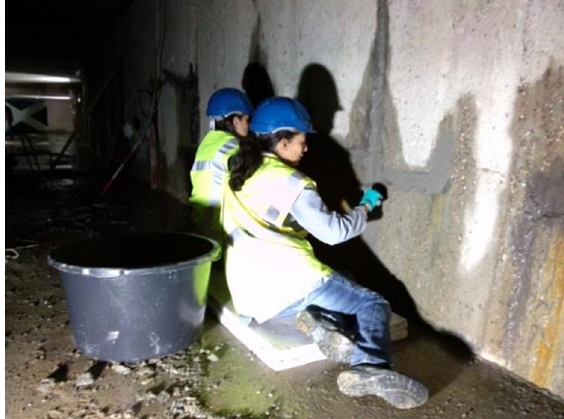
Figure 6. Manual repair of actively leaking cracked concrete basement walls using bacteria ‐ based self ‐ healing repair